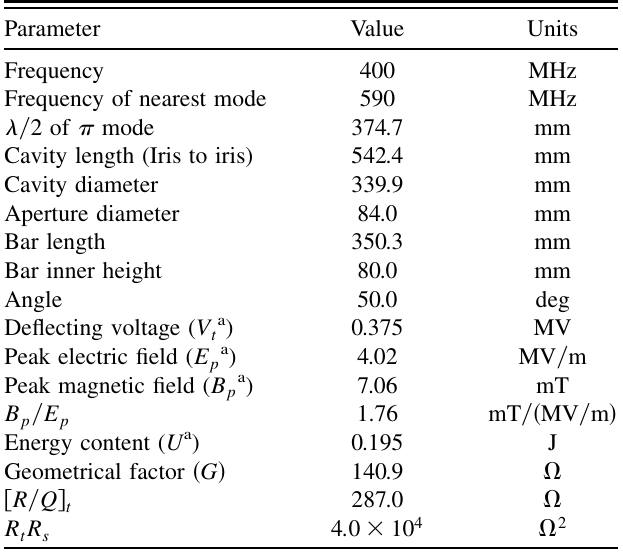
TABLE I. Properties of the rf-dipole geometry shown in Figs. 1 and 4.